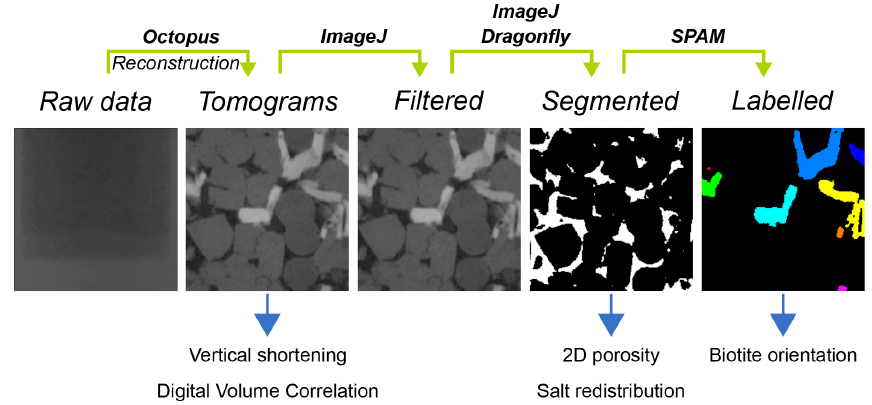
Figure 3. Workflow used for data processing. At the top, the specific software used in each processing step is given, while the information gained from the individual steps is listed below a representative 2-D slice of the particular processing result. The individual steps are based on each other going from the left (the unprocessed radiograph) to the right (highly processed